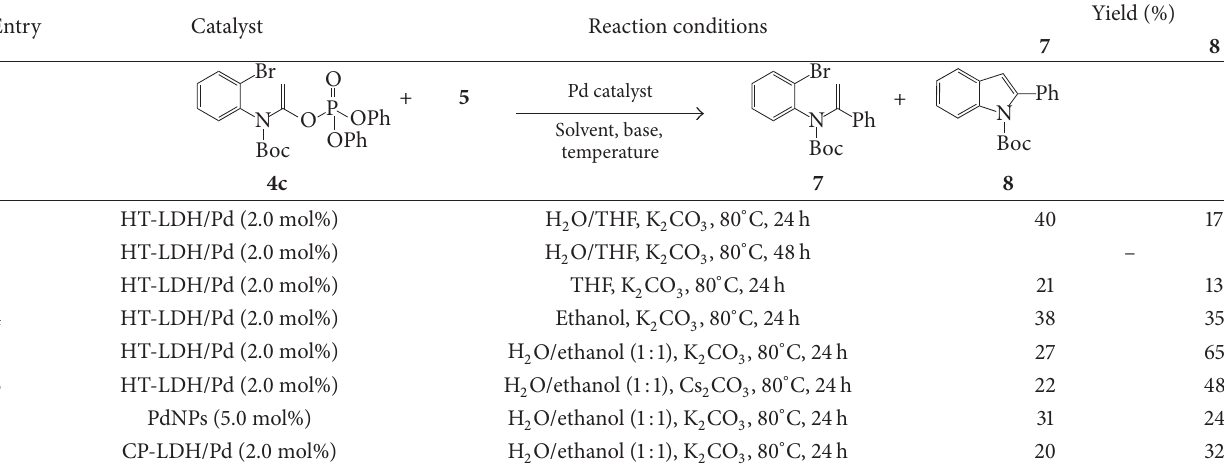
Table 2: Screening of the reaction conditions for the synthesis of the 2-phenyl indole from the N -Boc protected enol phosphate. Entry Catalyst